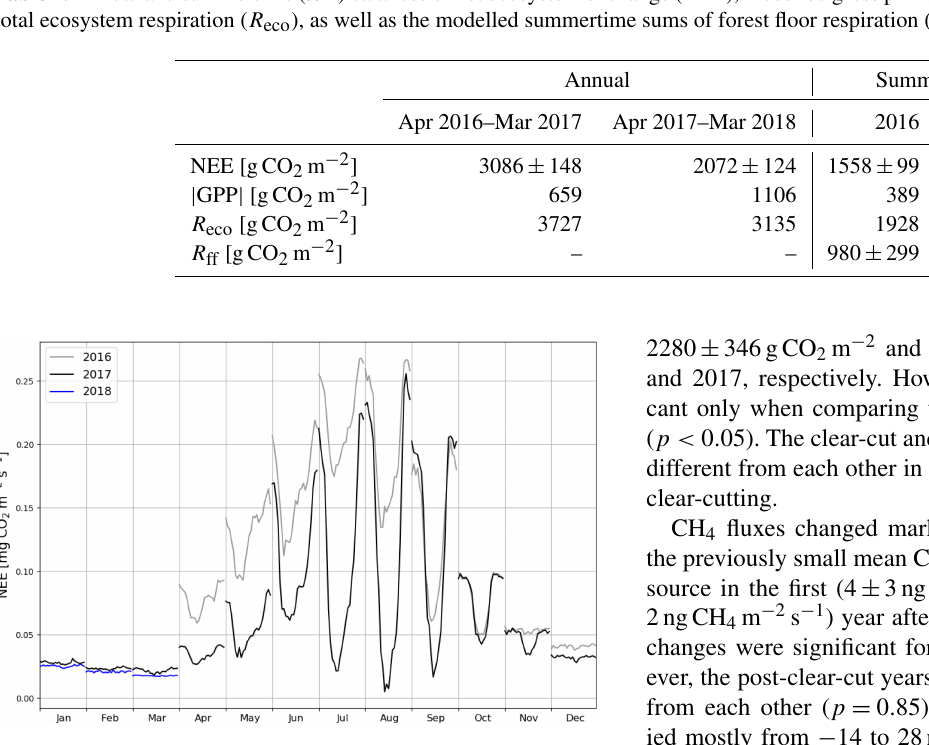
Figure 6. Monthly mean diel cycles of gap-filled net ecosystem ex- change (NEE) measurements in the first (2016, grey), second (2017, black) and third (2018, blue) calendar year after the clear-cutting.